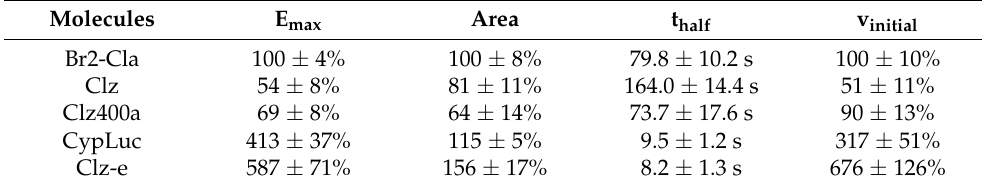
Table 2. Light-emission intensity maximum (E max , in RLU), calculated area of total light-emission (area, in RLU), light-emission half-life (t half , in s) and initial velocities (v initial , in RLU s − 1 ), for CL reactions of Br2-Cla, Clz, Clz400a, CypLuc and Clz-e in DMF. Measurements were performed in solutions with a final concentration of 0.73 µ M. Values are presented in percentage (%), with the results for Br2-Cla as